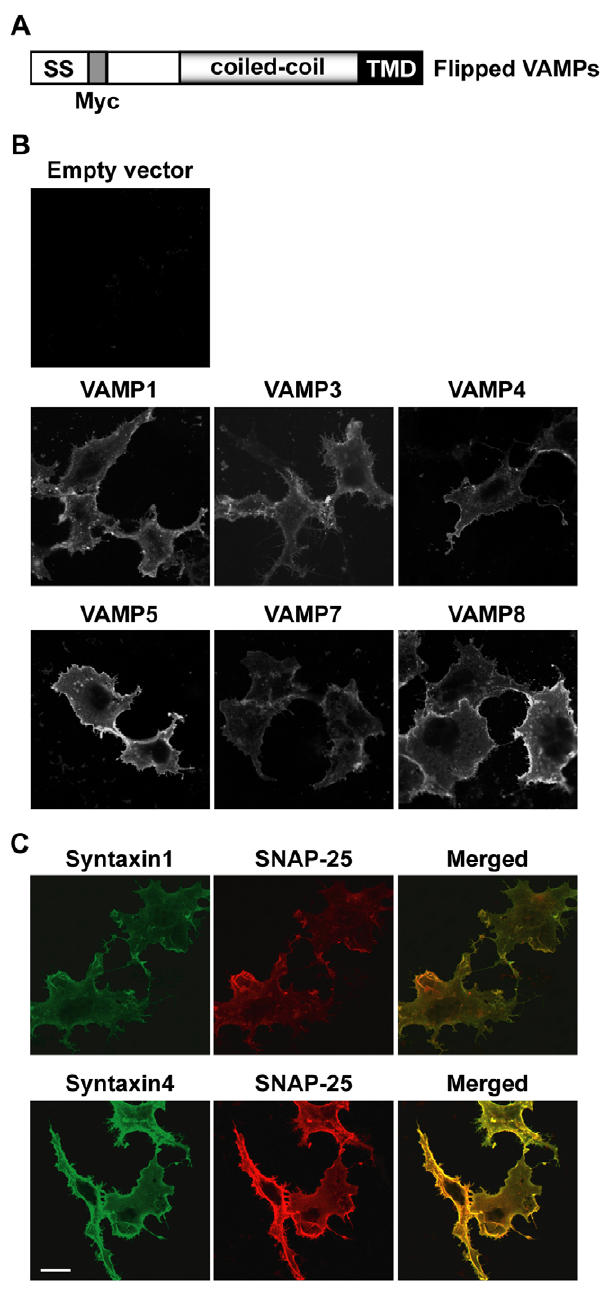
Figure 2. Expression of flipped SNARE proteins at the cell surface. (A) Domain structure of flipped VAMPs. The preprolactin signal sequence (SS) was fused to the N-termini of VAMPs 1, 3, 4, 5, 7 and 8. A Myc tag was inserted between the signal sequence and the VAMP proteins. (B) COS-7 cells were cotransfected with tTA and the empty vector pcDNA3.1( + ), flipped VAMPs 1, 3, 4, 5, 7 or 8. 24 h after transfection, unpermeabilized cells were stained with an anti-Myc monoclonal antibody to detect the expression of VAMPs at the cell surface. (C) COS-7 cells were cotransfected with TRE- LacZ , flipped SNAP- 25 and syntaxins 1 or 4. 24 h after transfection, unpermeabilized cells were dual labeled with antibodies. Syntaxins 1 and 4 were labeled with the anti-Myc monoclonal antibody (green), and SNAP-25 was labeled with a polyclonal antibody (red). Representative confocal microscopy images of four independent experiments are shown. Scale bar, 20 m